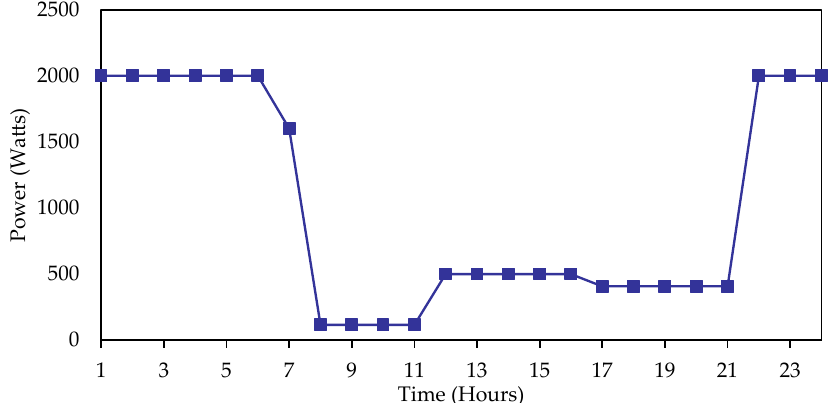
Figure 5. Demand curve of residential load.